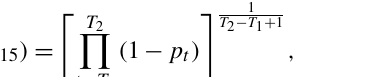
linear and exponential functions were considered to char- acterize the time-varying copula parameters and generally formulated as